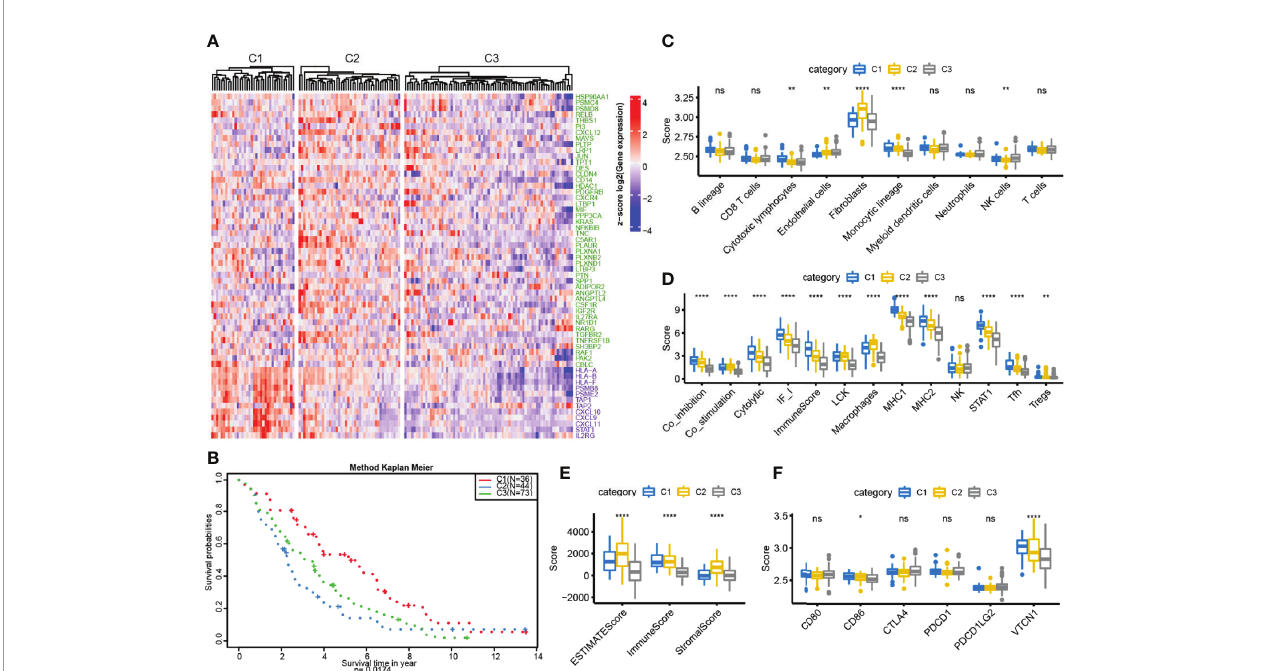
FIGURE 6 | OC immunotyping based on IRGs in validation set. (A) Gene expression heatmap of OC immune subtypes. (B) The K-M curve of the overall survival rate of the immune subtypes in the validation dataset, measured by log rank test. (C) 10 immune components difference in each subtype. (D) The differences of 13 kinds of immune components in different subtypes. (E) The box plot of immune score difference in each subtype was calculated by ESTIMATE. (F) The expression differences of 6 common immune checkpoint genes among three subtypes. *P < 0.05, **P < 0.01, ****P < 0.0001, and ns ‘ No Signi fi cant ’ .